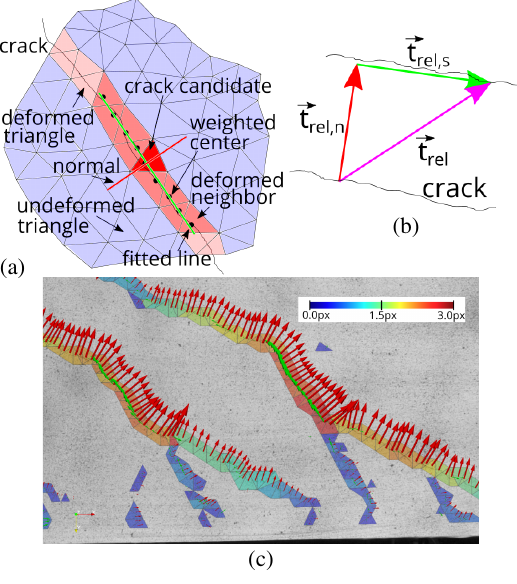
Figure 4. (a) Crack normal estimation, based on (Liebold and Maas, 2018); (b) decomposition of the deformation vector; (c) vector field of the normal (red) and the shear components (green) of the deformation vector (scale factor: